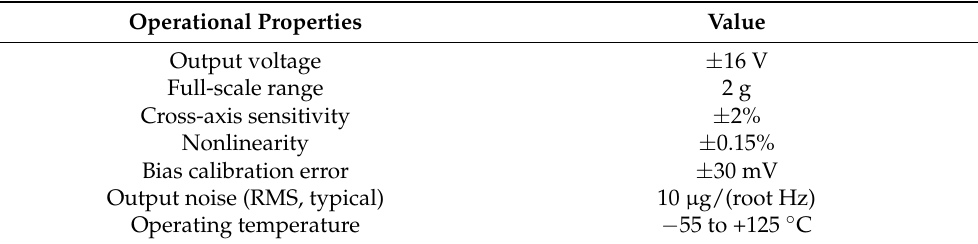
Figure 5. Location of hammer impacts, sensor names, and orientation. Table 1. Specifications of accelerometers used in this experimental test.